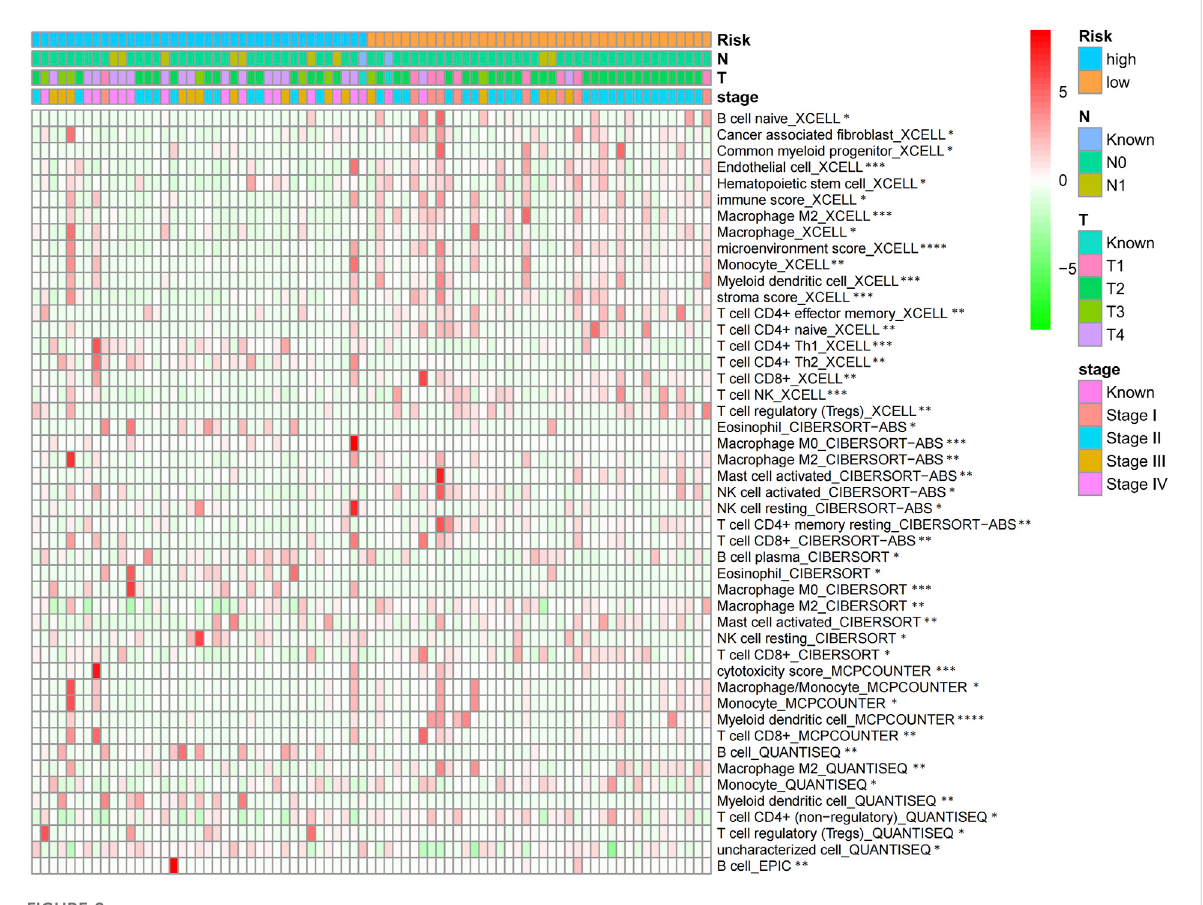
FIGURE 8 Heat map of CR signature with immune in fi ltration by TIMER